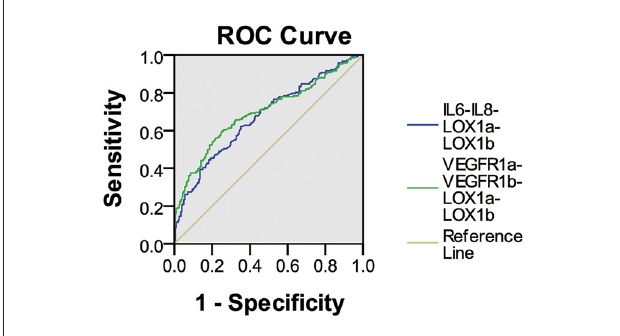
FIGURE1 ROC curve analysis of plasma IgG NAbs against two peptide combinations in ischemic stroke. The IL6-IL8-LOX1a-LOX1b combination had an AUC of 0.67 (95% CI 0.623–0.725) for the IgG assay with a sensitivity of 21.1% against the specificity of 95.5%, and the VEGFR1a-VEGFR1b-LOX1a-LOX1b combination had an AUC of 0.70 (95% CI 0.648–0.748) for the IgG assay with a sensitivity of